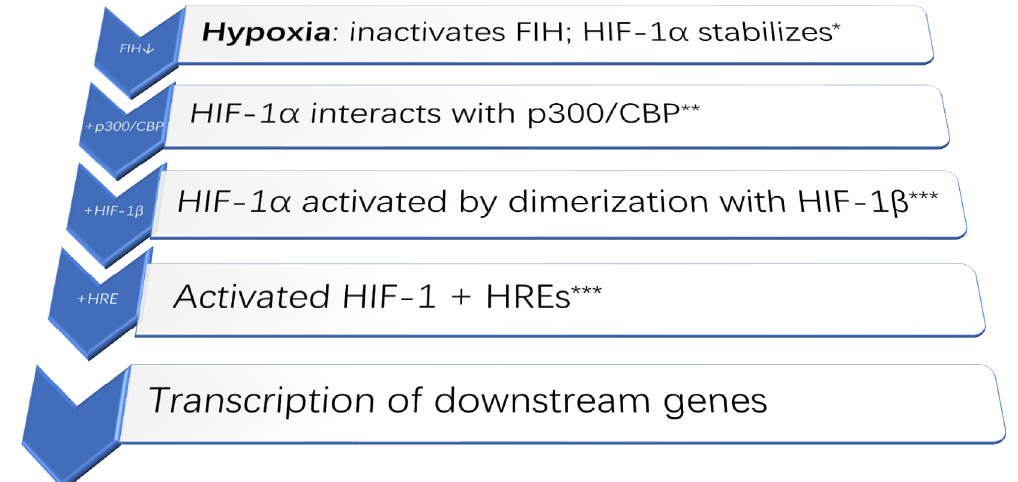
Figure 1. Schematic diagram of the main molecular event upon hypoxia. HIF-1α + HIF-1β + HREs would activate the transcription of downstream genes [12]. * FIH: factor inhibiting HIF [13]; ** p300/CBP: p300/CREB binding protein (transcriptional coactivators) [14 ]; *** HREs: hypoxia-response elements; “↓”: inhibited; “+”: added